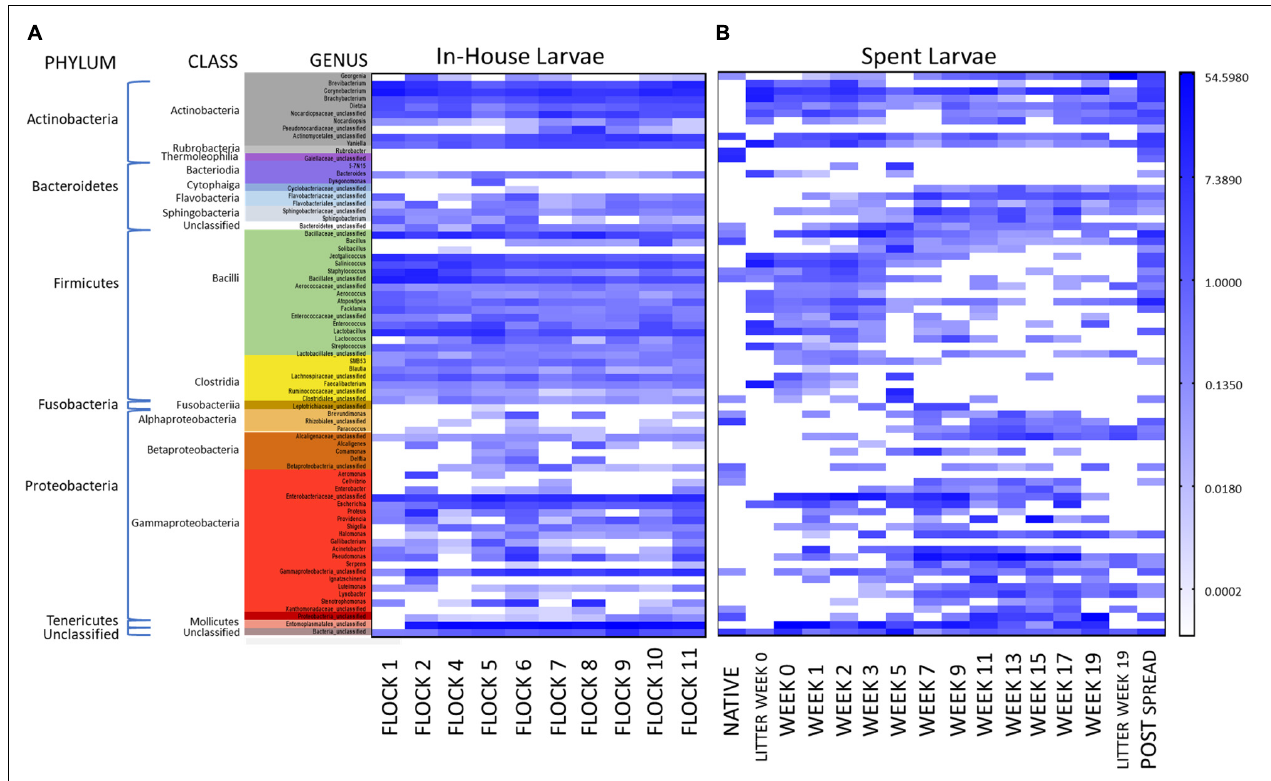
FIGURE 4 | A heatmap of percent abundance of the top 55 identified genera sequences (unweighted) in the LML from the (A) In-House (grouped by class) collected during the flock rotations and (B) pastureland soil prior to deposition of the spent litter (Native Soil), samples of the spent litter at the time of deposition into the pastureland and just prior to spreading (Litter Week 0 and Litter Week 19, respectively); the soil/litter combination after spreading onto the pastureland (Post Spread); and the larvae collected from that litter over the 19 weeks of stockpiling (Week 0 through Week 19). For natural log transformation “0” was converted to “0.01.”